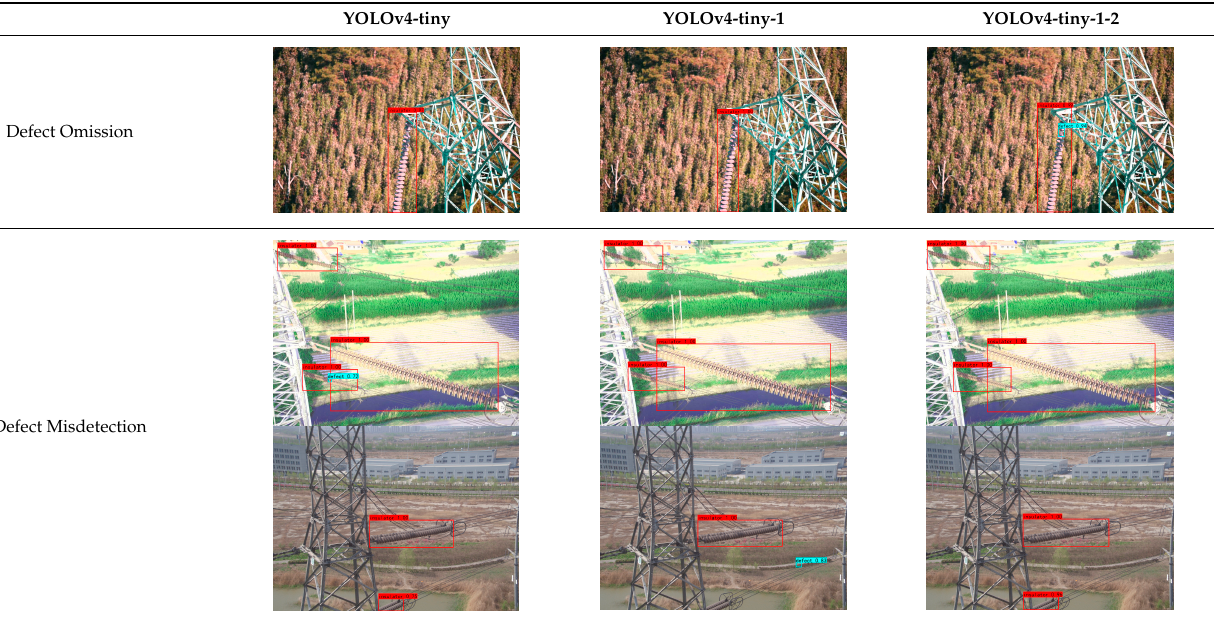
Table 8. Improvement comparison of the defect detection.